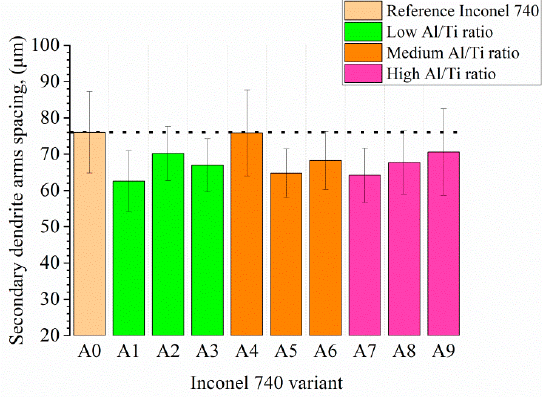
Figure 5. Secondary dendrite arm spacing in fabricated castings.